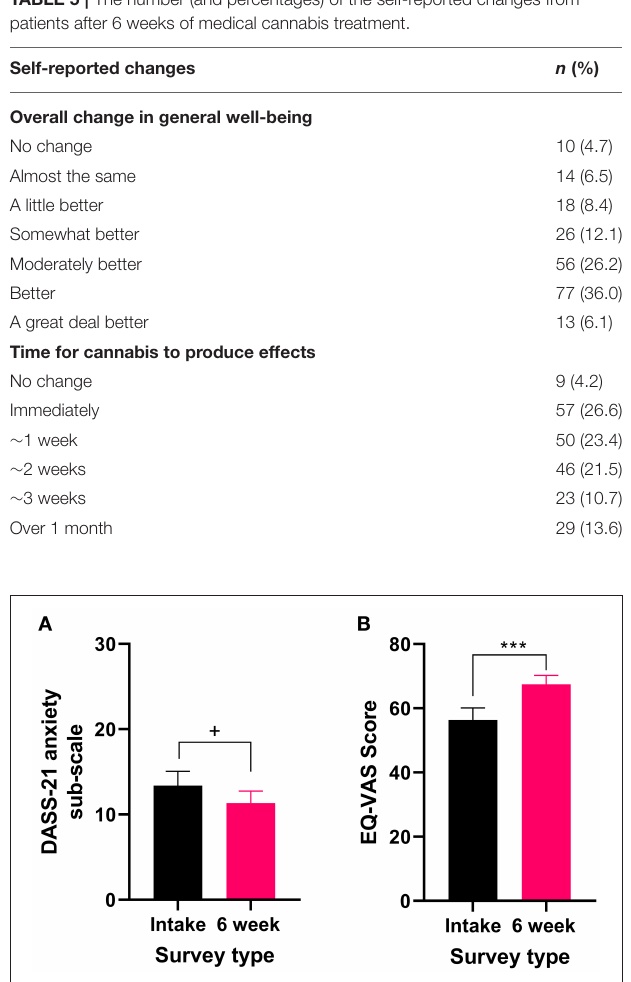
FIGURE 3 | Validated survey scores from the intake survey (baseline) and 6-week follow-up survey for patients reporting anxiety as their primary medical condition. There was an improvement in QOL after 6 weeks of medical cannabis treatment. (A) DASS-21 anxiety sub-scale scores were not significantly altered after 6 weeks of medical cannabis treatment ( t 32 = 1.875 P = 0.07), but there was a trend toward improvement. (B) EQ-VAS score significantly improved from the intake survey to the 6-week follow-up survey (Wilcoxon test P < 0.001), (*** P < 0.001, + P = 0.07).